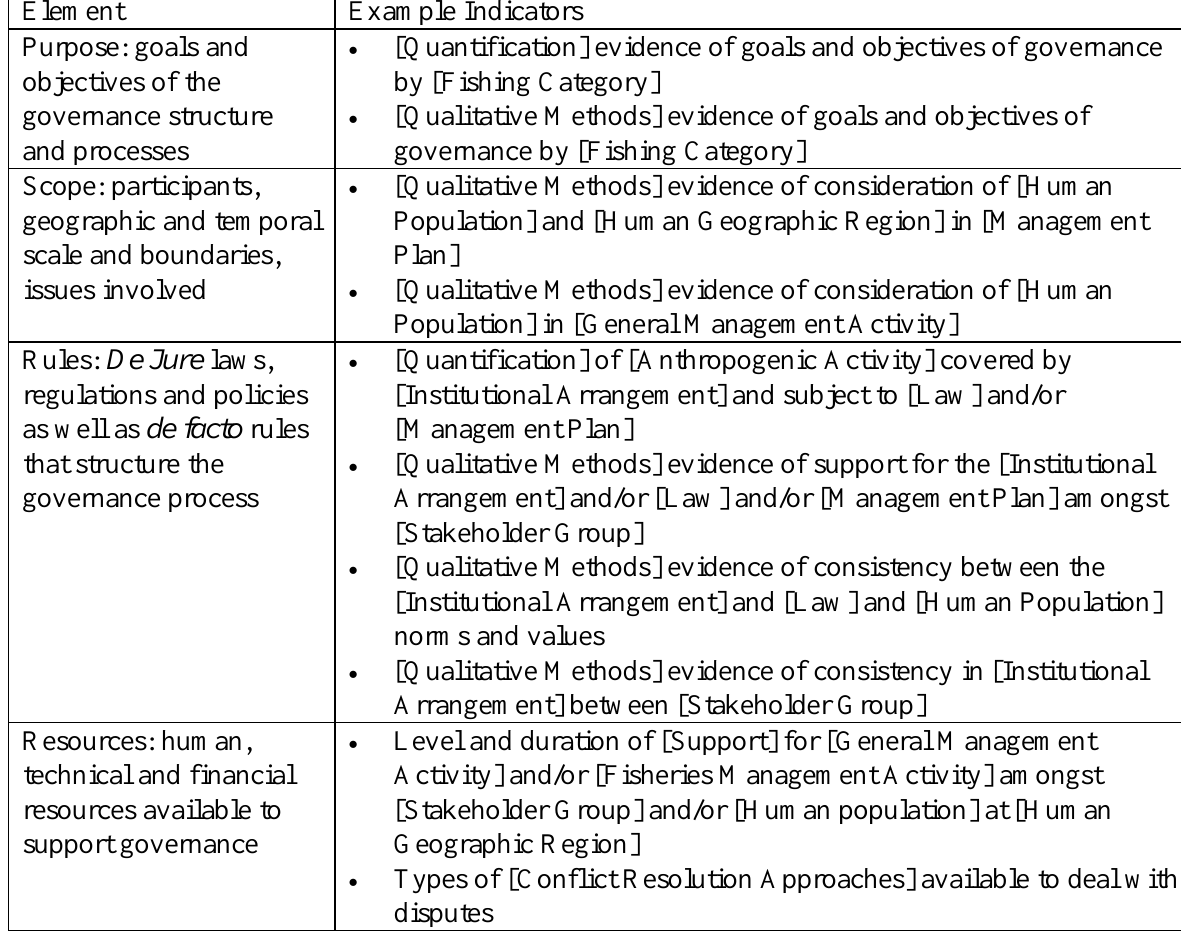
Table A1.1: Institutional Arrangements Dimension – Example Indicators